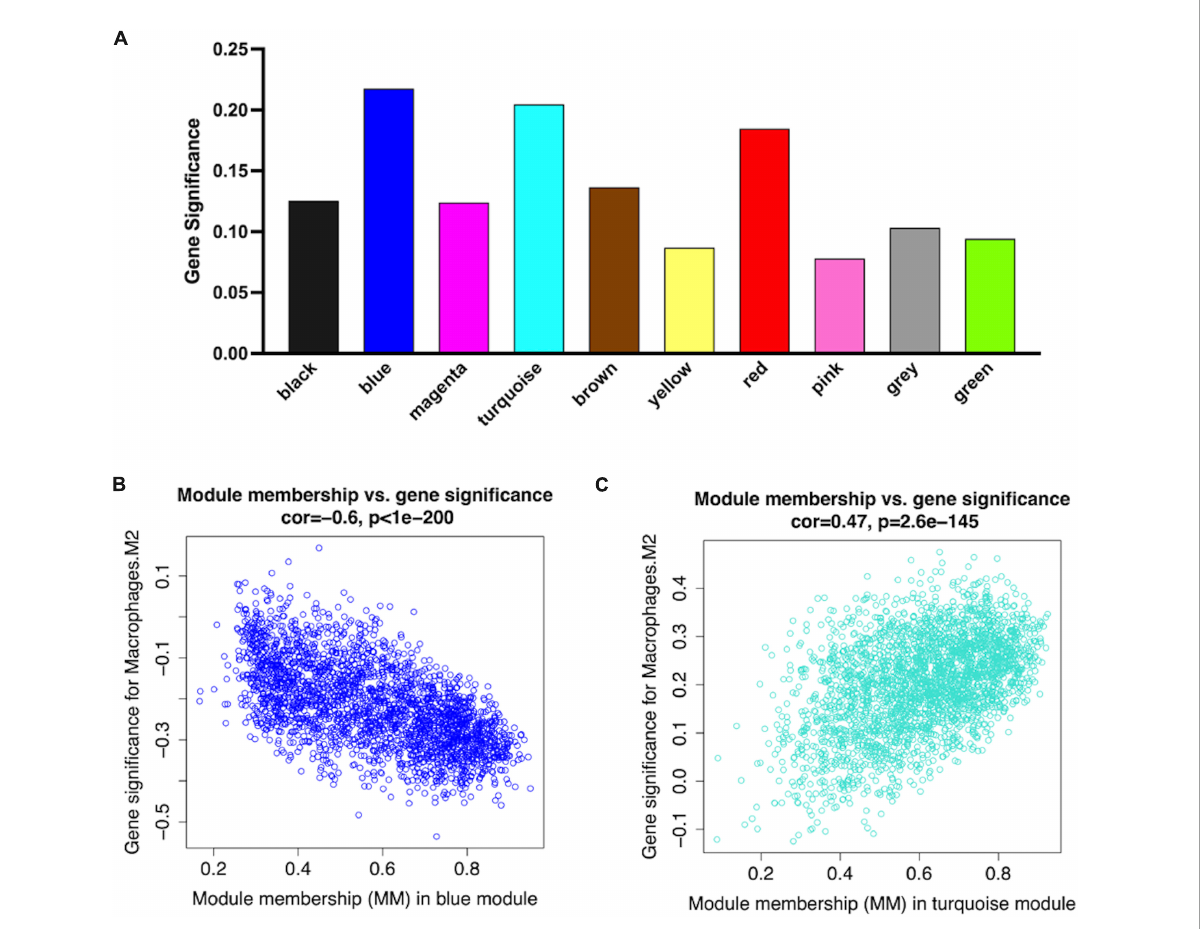
FIGURE5 Network plots of module and eigengene. (A) Bar plots of mean GS in distinct modules. The higher value of mean GS indicates more significant correlation between macrophages M2 and the module (B,C) . Scatterplots in two hub modules with GS ( y -axis) and MM ( x -axis)